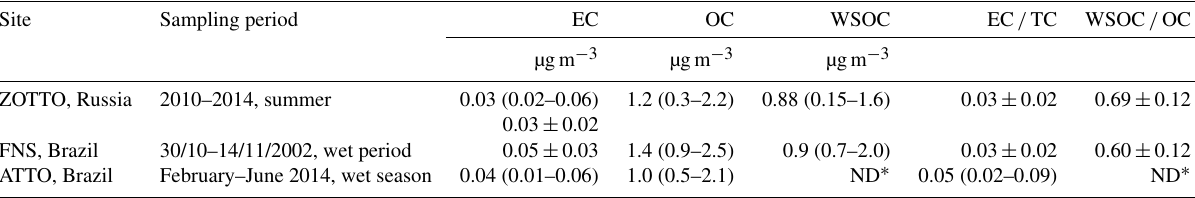
Table 6. Average background concentrations of carbonaceous species ( ± SD) or min–max as well as their ratios obtained at FNS (Rondônia, Brazil) and at the ATTO site (Amazonas, Brazil) during the wet period and those measured in summertime at ZOTTO.